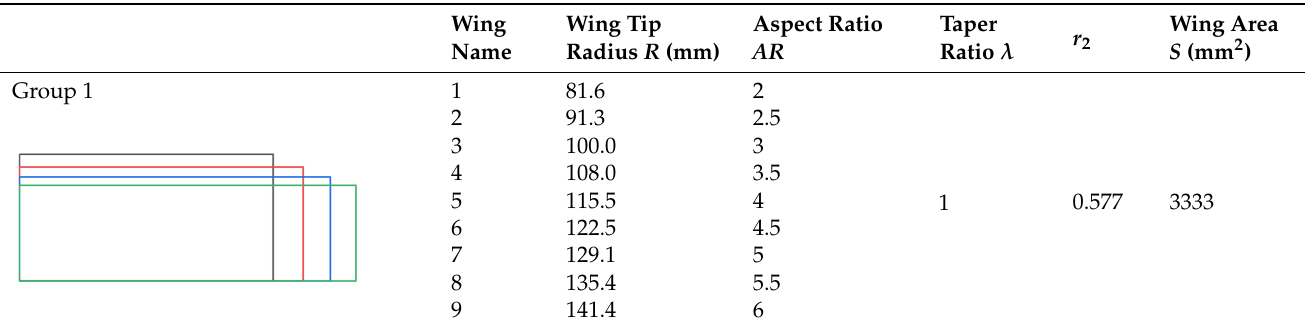
Table 1. List of designed wings with various AR and S .